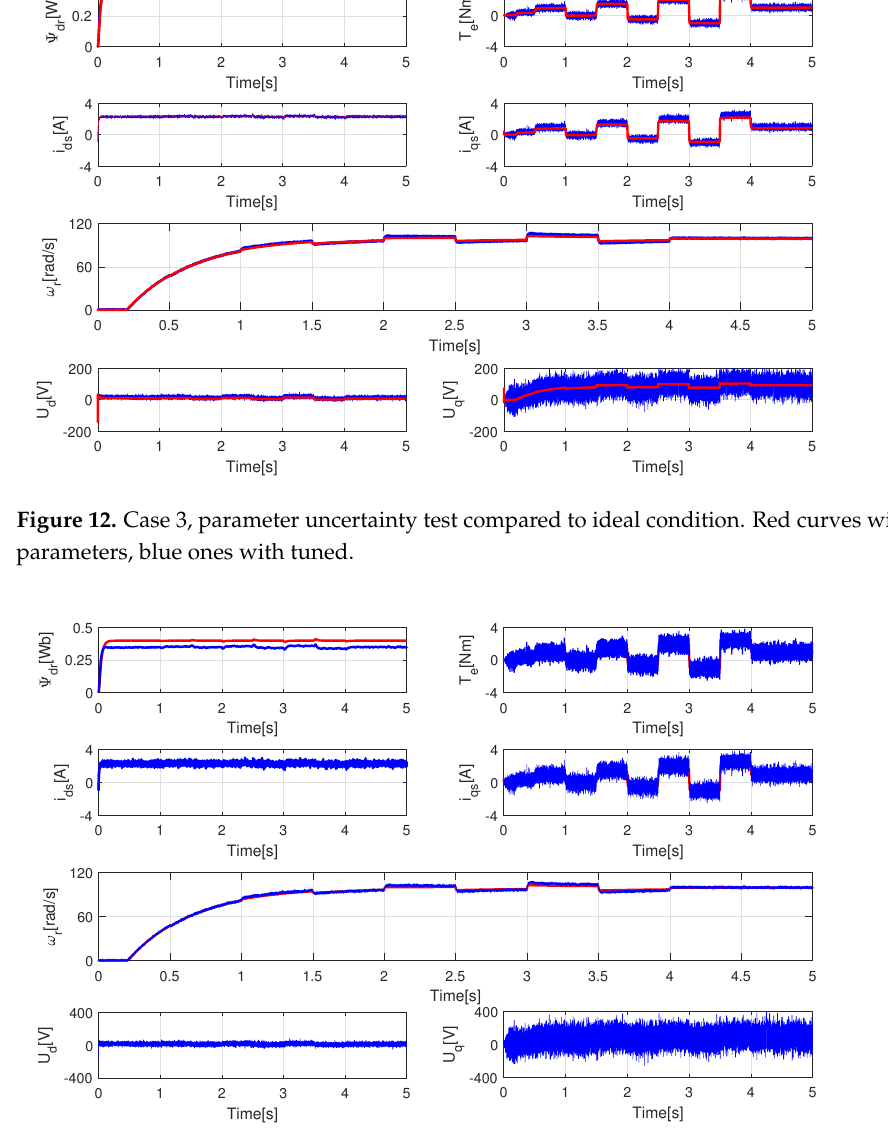
Figure 13. Case 4, parameter uncertainty test compared to ideal condition. Red curves with nominal parameters, blue ones with